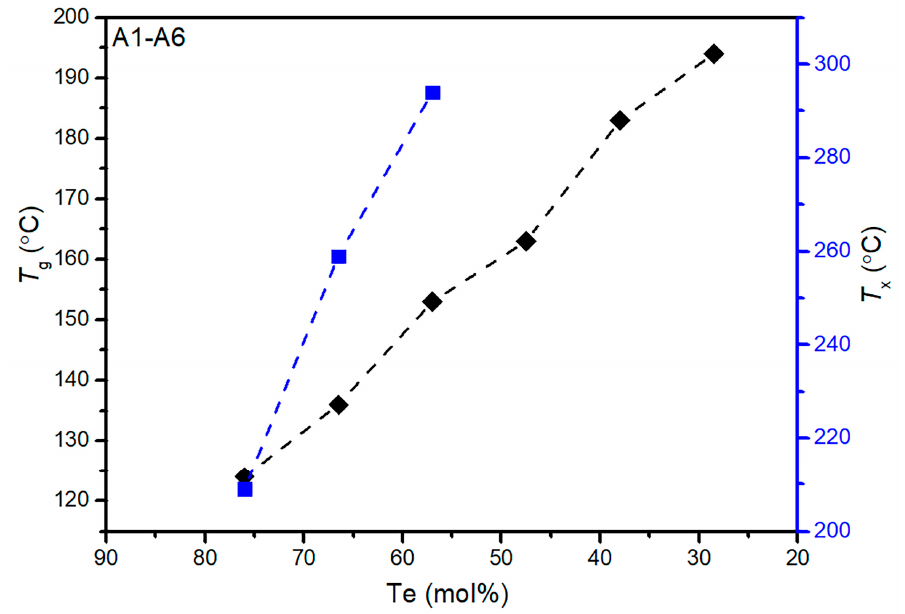
Figure 4. T g and T x values of A1–A6: Se 5 (Ge 0.1 As 0.9 − x Te x ) 95 ( x = 0.8, 0.7, 0.6, 0.5, 0.4, 0.3) glasses.